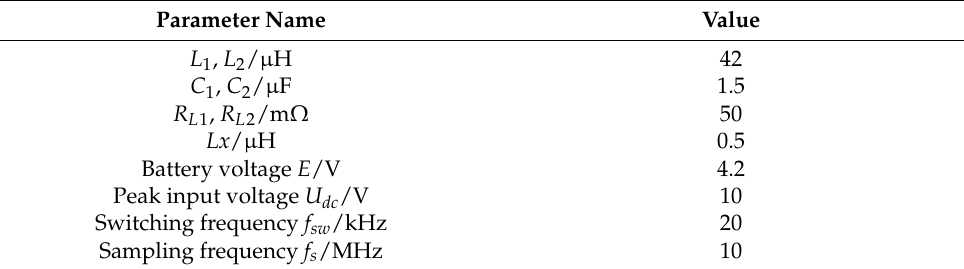
Table 1. Simulation